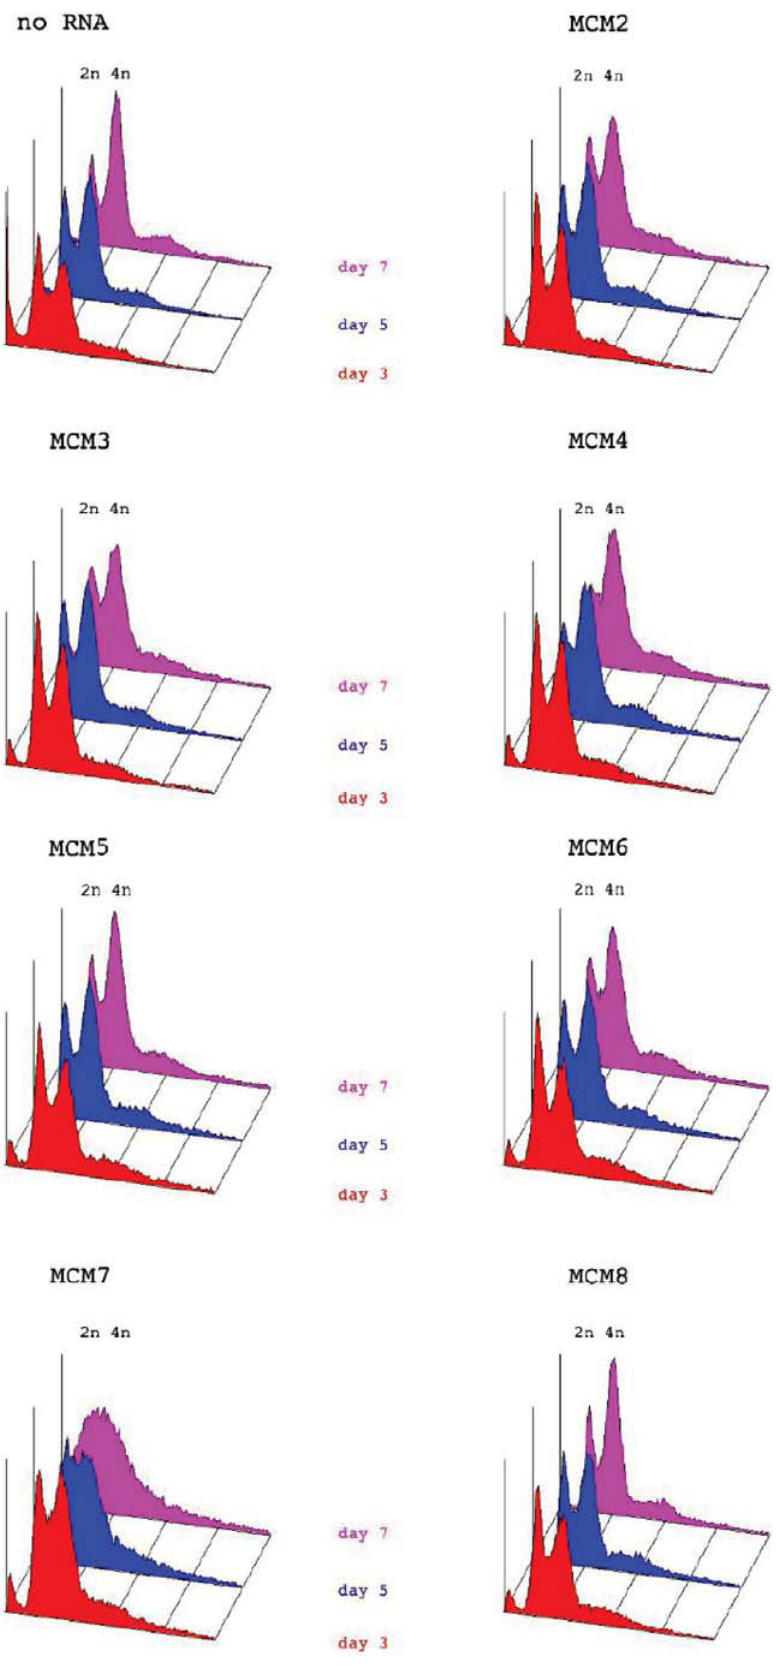
Figure 5. FACS analysis profiles of cells targeted with dsRNA against MCM2-7 proteins as compared to control targeted cells. The data presented is one complete representative data set from multiple repetitions. doi:10.1371/journal.pone.0000833.g005 PLoS ONE |